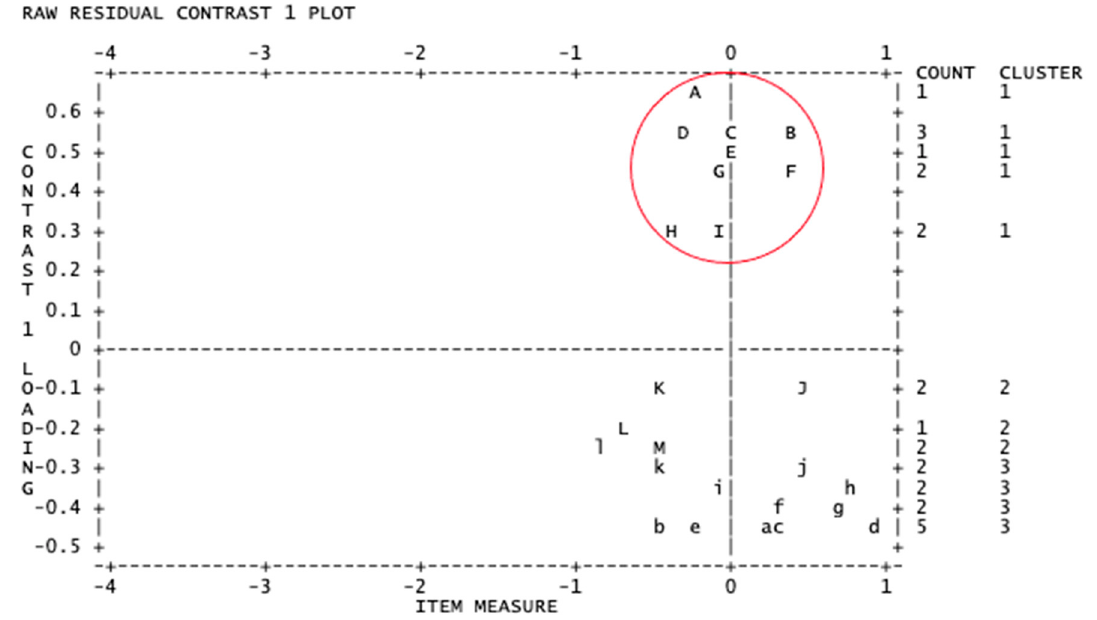
Figure 1. Principal components plot of item loadings. Letters represent items, with cluster A–I representing items 17–25 (Resilience subscale). As demonstrated, the first cluster of the Resilience subscale items has a notably disparate Y -axis difference from the remainder of the items that indicate Psychological Distress, evidencing a multidimensional structure to the measure, thereby indicating a unidimensional scale score is likely to be inappropriate.